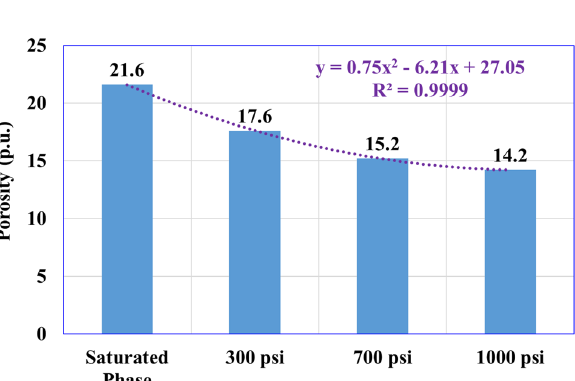
Figure 6. Internal pore system changes with the overbalance pressure. ( a ) Initial saturated core. ( b ) Under 300 psi overbalance. ( c ) Under 700 psi overbalance. ( d ) Under 1000 psi overbalance.